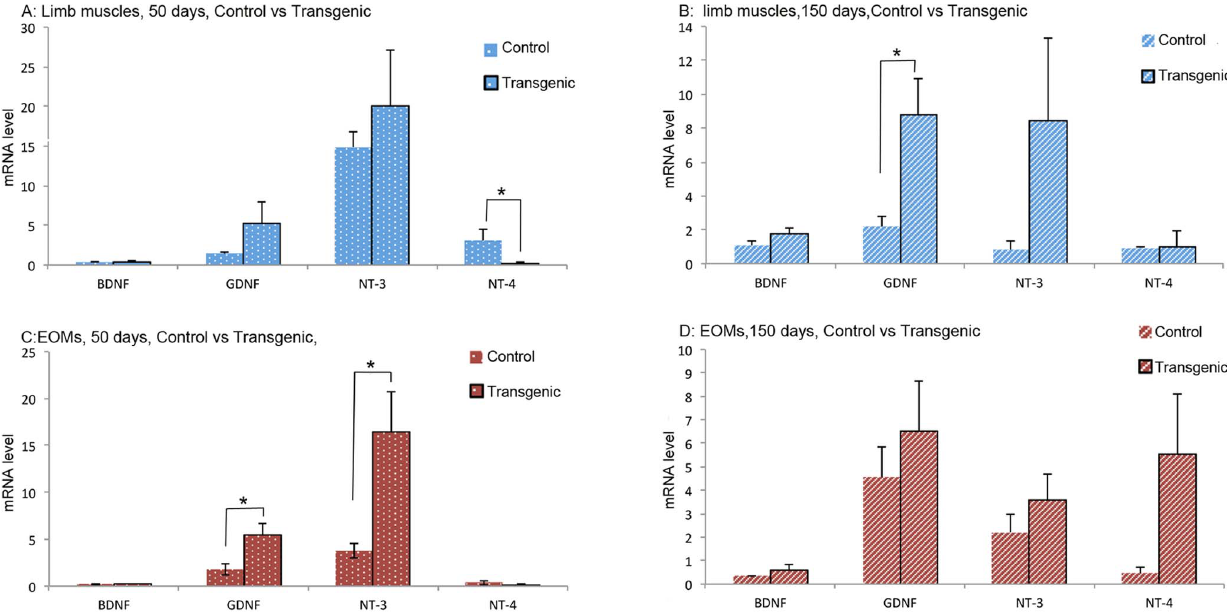
Figure 4. mRNA levels of NTFs in limb muscles and EOMs from early and late stages ALS mice and from age-matched control mice. Top panels: comparison of NTF expression in limb muscles between ALS mice and control mice of 50 days (A) and 150 days of age (B). Bottom panels: comparison of NTF expression in EOMs between ALS mice and control mice of 50 days of age (C) and 150 days (D). The expression levels are given using arbitrary units normalized by b -actin expression. Bars represent mean 6 SD from analysis of at least 5 separate samples run in triplicate. *: p , 0.05.